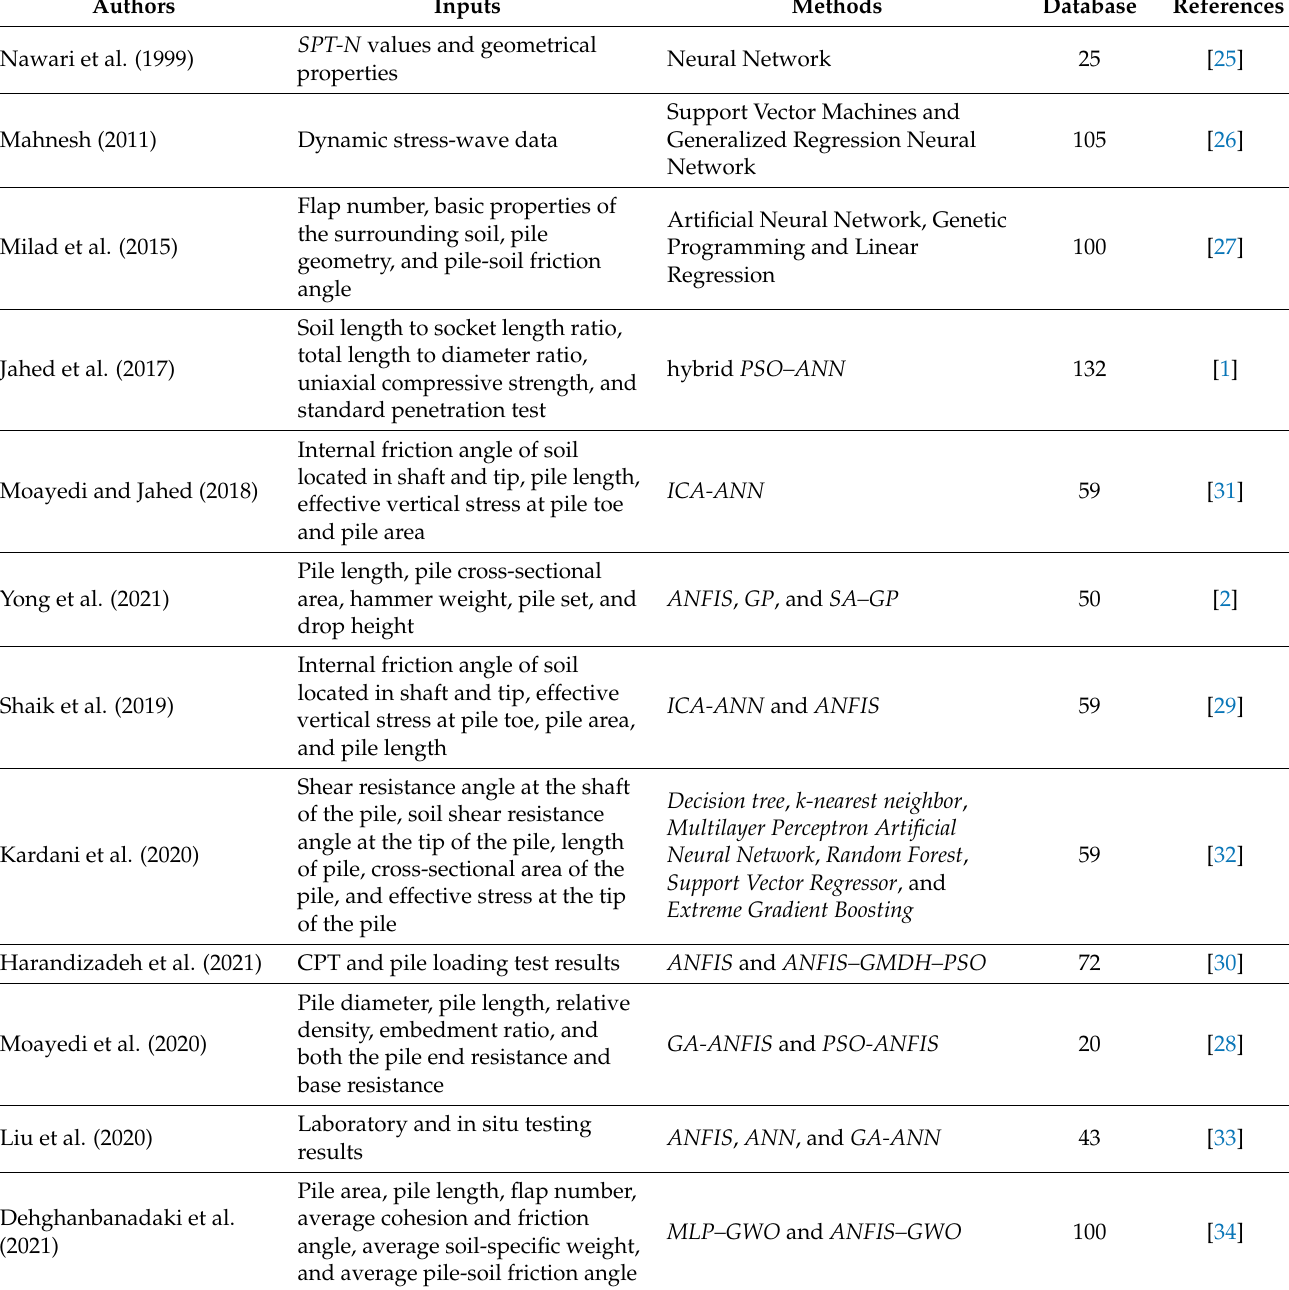
Table 1. Proposed machine-learning models in the literature to estimate the pile-bearing